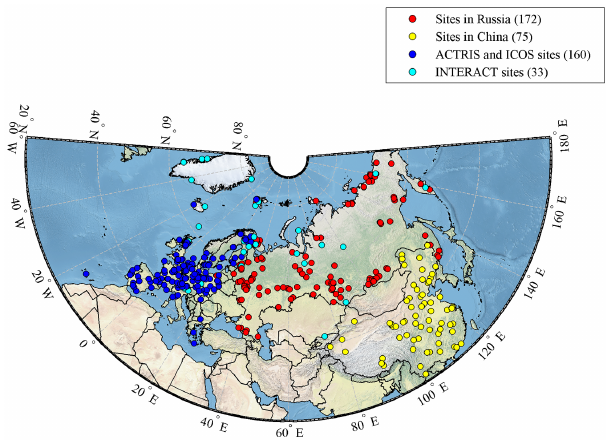
Figure 3. Map showing the existing ACTRIS (aerosols, clouds, and trace gases research infrastructure network) and ICOS (Inte- grated Carbon Observations System) stations in Europe (blue), sta- tions making atmospheric and/or ecosystem measurements in Rus- sia (red), INTERACT (International Network for Terrestrial Re- search and Monitoring in the Arctic) stations in Russia (light blue), and China Flux stations in China (yellow). However, all of these stations need certain